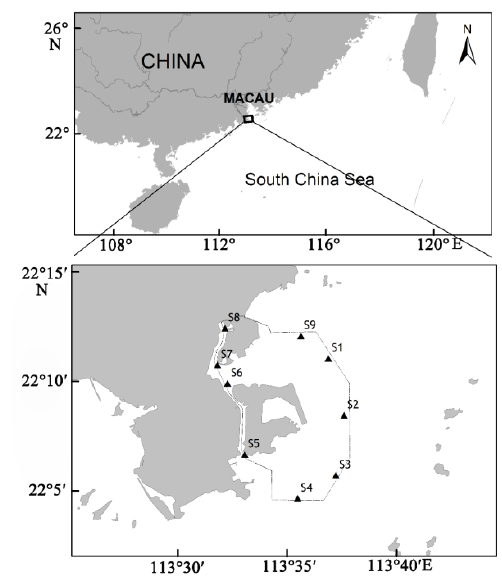
Figure 1. Location map of the sampling area.